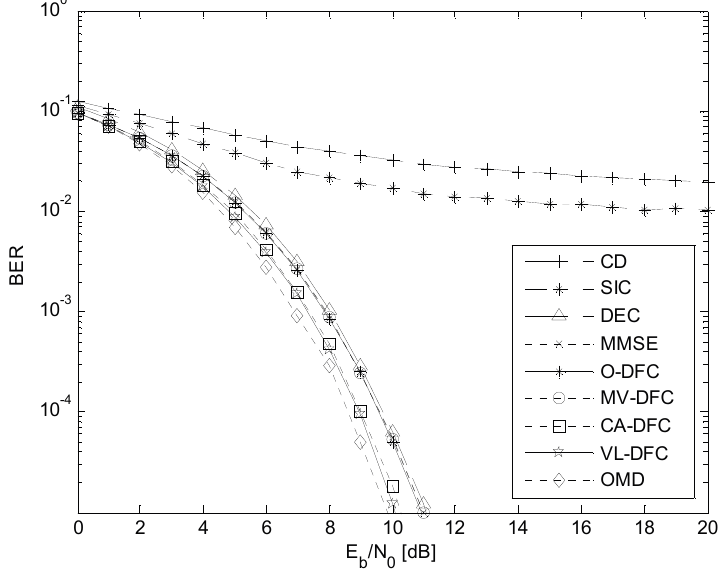
Figure 6. The BER versus E b / N 0 curves in AWGN channel when K = 10 and perfect power control is